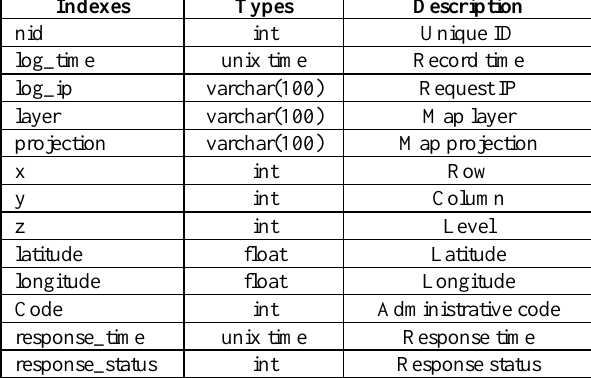
Table 2. Statistical index datasheet design for map